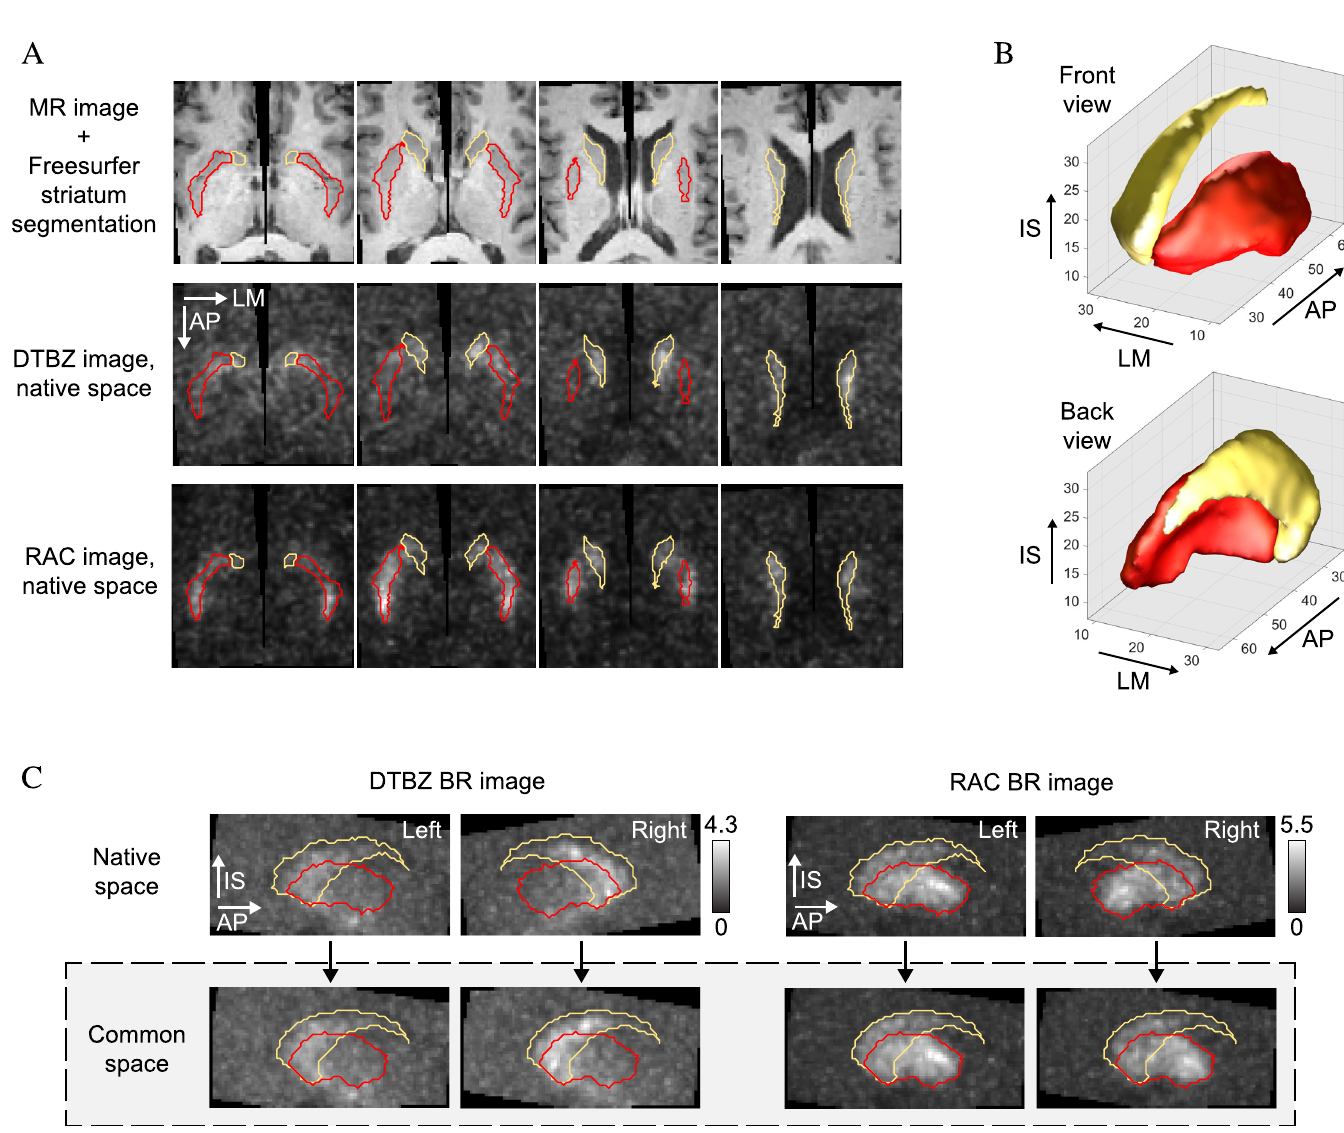
Fig 2. Examples of striatum images and segmentations in subject-native and common spaces. A: Segmented MR image, DTBZ and RAC images in the native space for a PD subject. B: Rendering of the striatal template from two views. To generate the template, Freesurfer segmentations of the MR images of the putamen and caudate in the HC subjects were rigidly co-registered and averaged (N = 10, one side chosen randomly from each subject). C: Comparison of DTBZ and RAC BR images in the subject-native and common spaces (PD subject, same as A). AP = anteroposterior, LM = lateromedial, IS = inferosuperior.